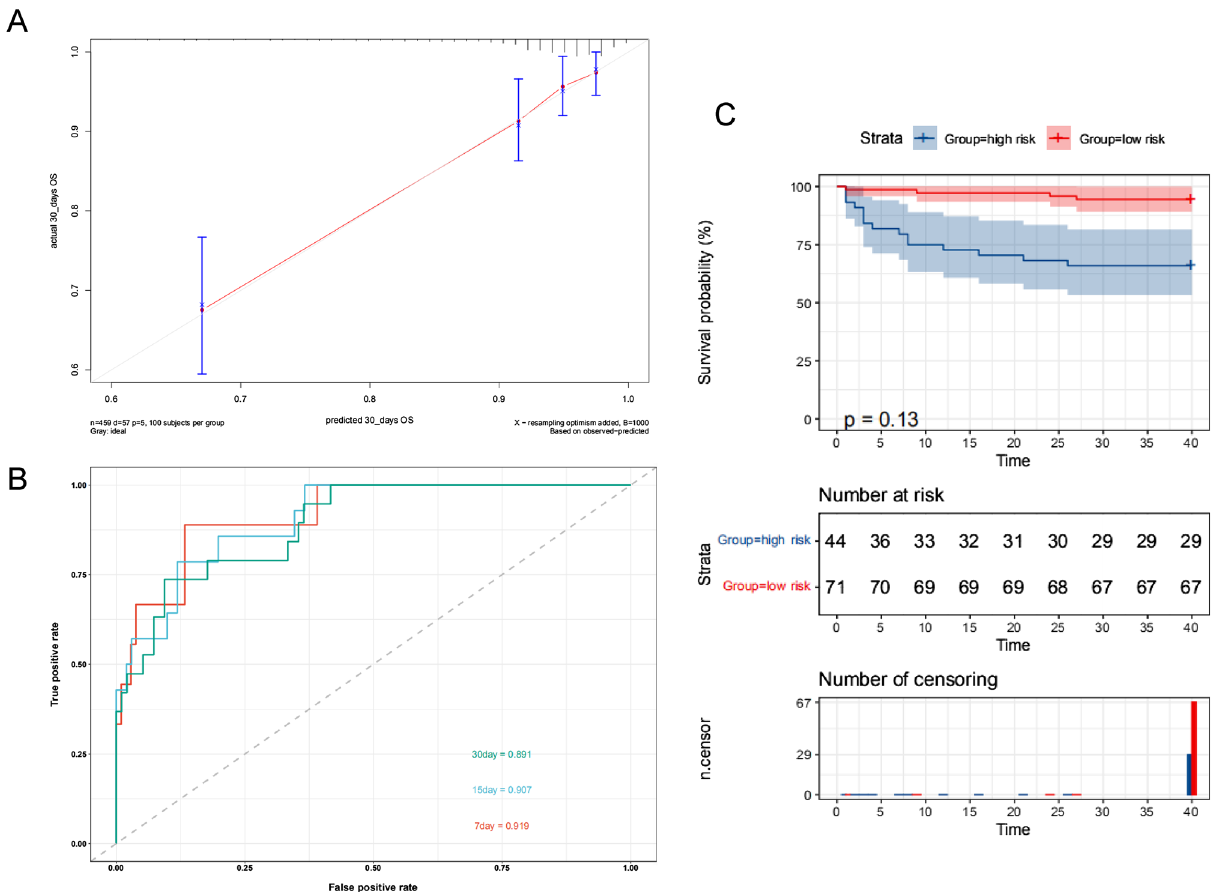
Figure 4. Estimation of the model applying in the new validation cohort. ( A ) Calibration curves. ( B ) ROC curves. ( C ) The K–M survival curves show the overall survival based on the high and low-risk patients divided by the optimal cut ‐ off